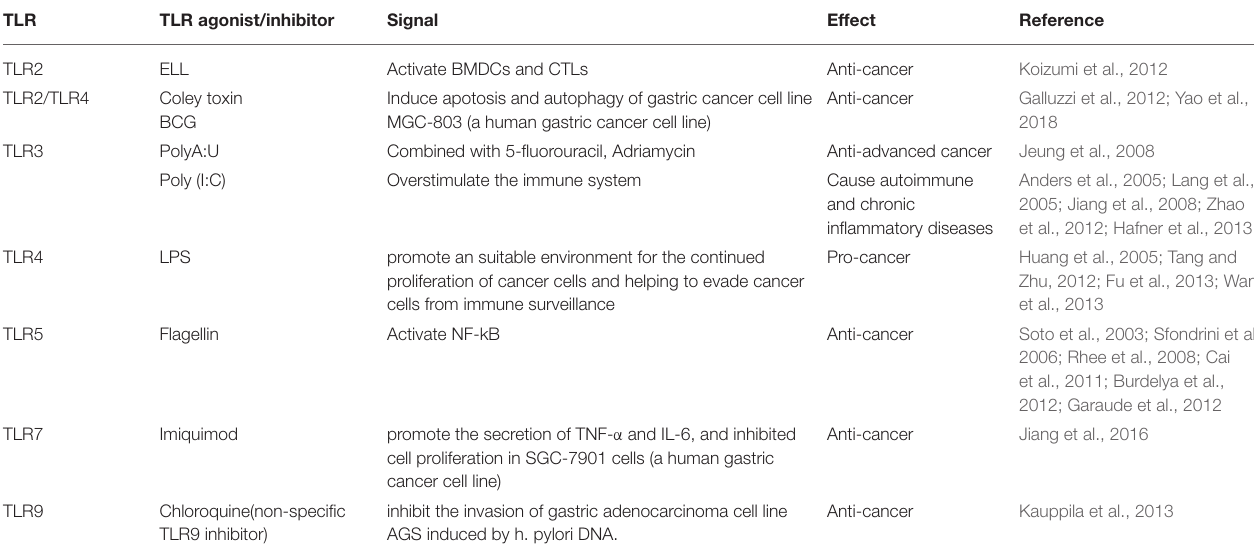
TABLE 1 | The agonists of TLRs in the immunotherapy of gastric cancer. TLR